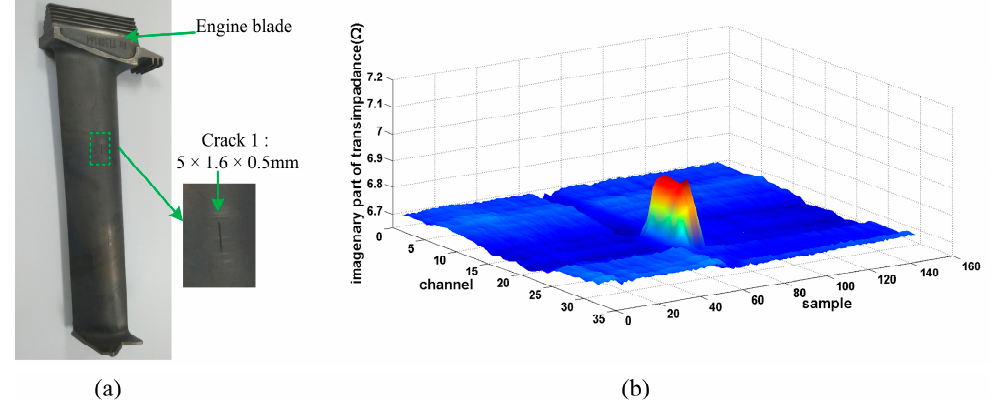
Figure 11. Scanning of engine blade. ( a ) Engine blade; ( b ) Image of crack.